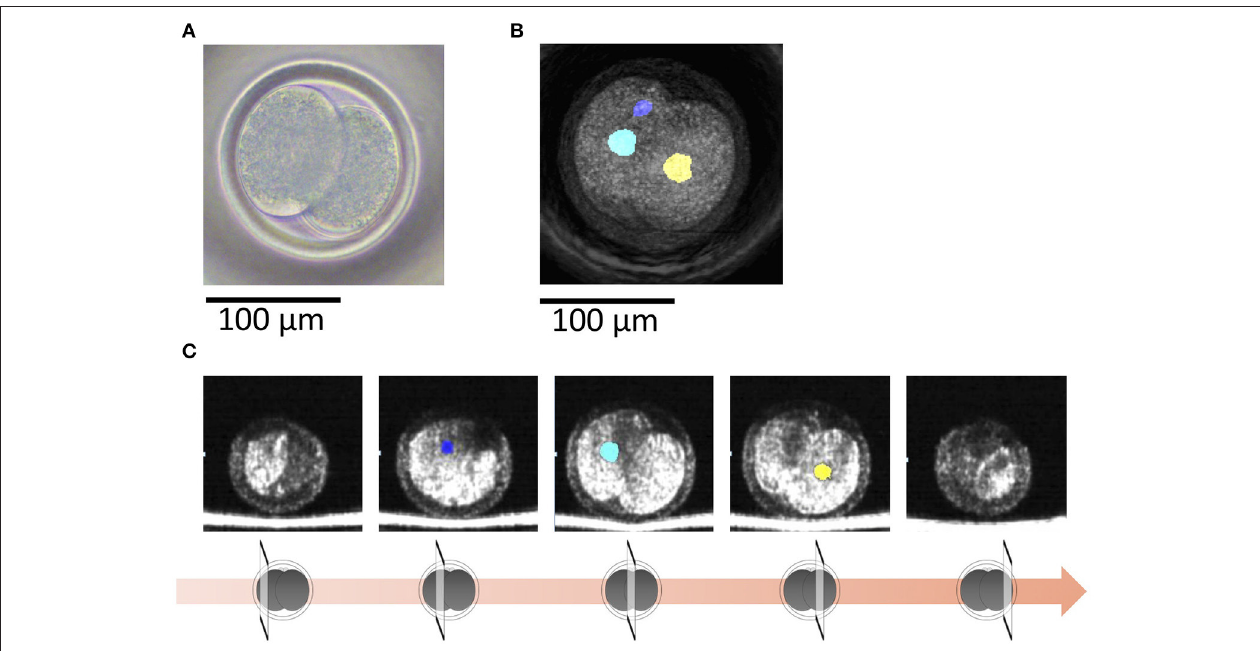
FIGURE 5 | (A) A bovine 2-cell embryo including a binuclear blastomere imaged by a microscope. (B) Optical coherence tomography (OCT) images of the bovine 2-cell embryo including a binuclear blastomere with visualization of the nucleus (blue, green, and yellow) of the blastomere. Blue and green nucleus are in a blastomere. (C) Tomographic images obtained by OCT imaging. Panels are images shifted by 25 µ m from the center of the embryo with visualization of the nucleus (blue, green, and yellow) of the